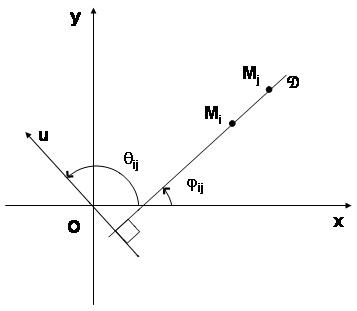
Construction of the critical angle θij of the direction u. - the geographical space is represented by the plane with an orthogonal basis {x, y} and a fixed origin O; - u is a direction perpendicular to the splitting direction ; - Mi and Mj are two point locations in the geographical space.